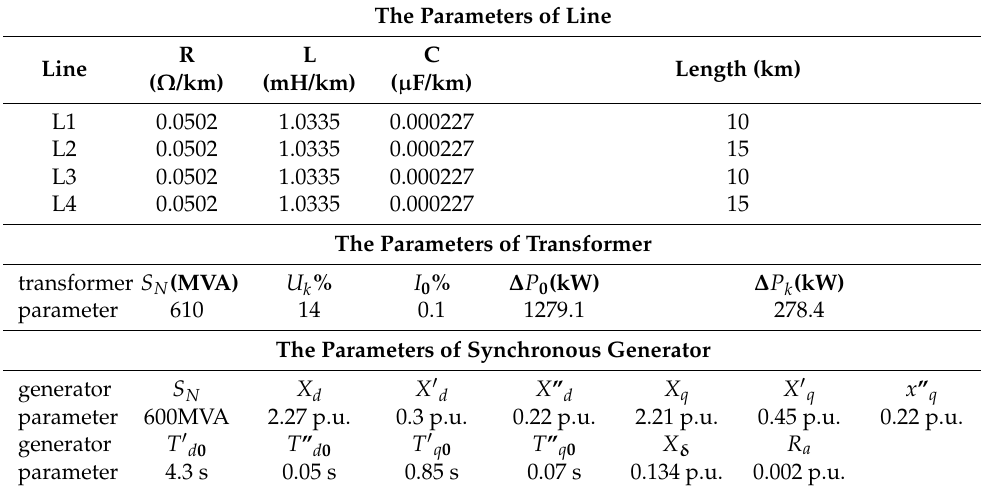
Table 3. The parameters of the equipment in the AC system. The Parameters of Line